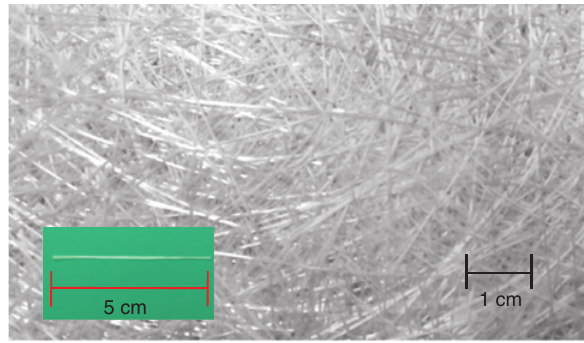
Figure 1 Glass fiber chopped strand mat.